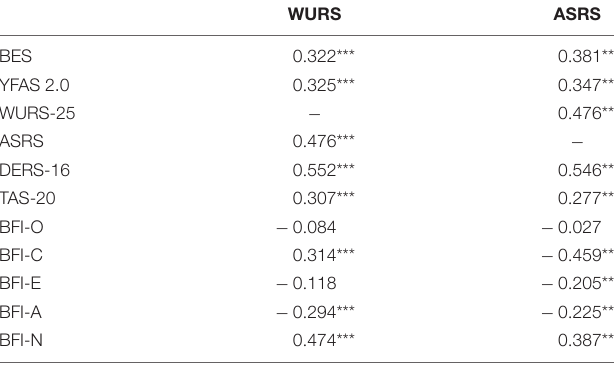
TABLE 3 | Spearman correlation matrix between ADHD variables and psychopathological